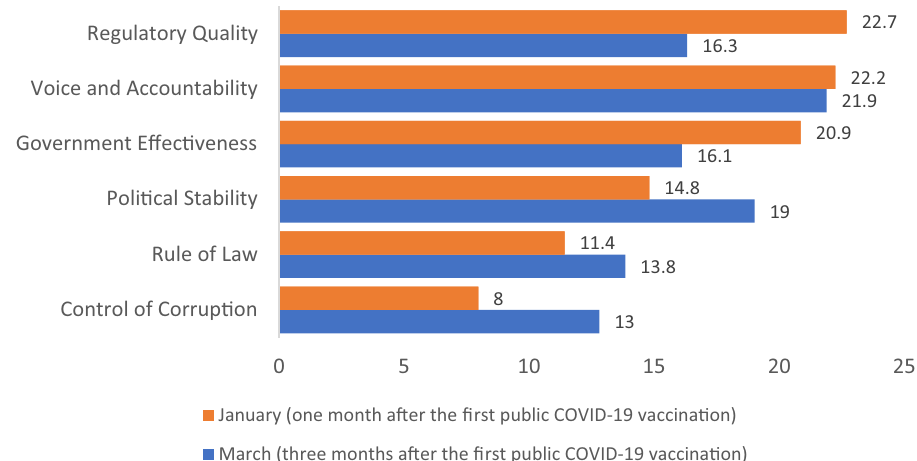
Figure 4. Good Governance Feature (Indicator) Gain Relative Importance. Gain denotes indicator’s (feature) relative contribution in explaining variation in outcomes. A higher indicator gain implies greater importance of the indicator for generating a